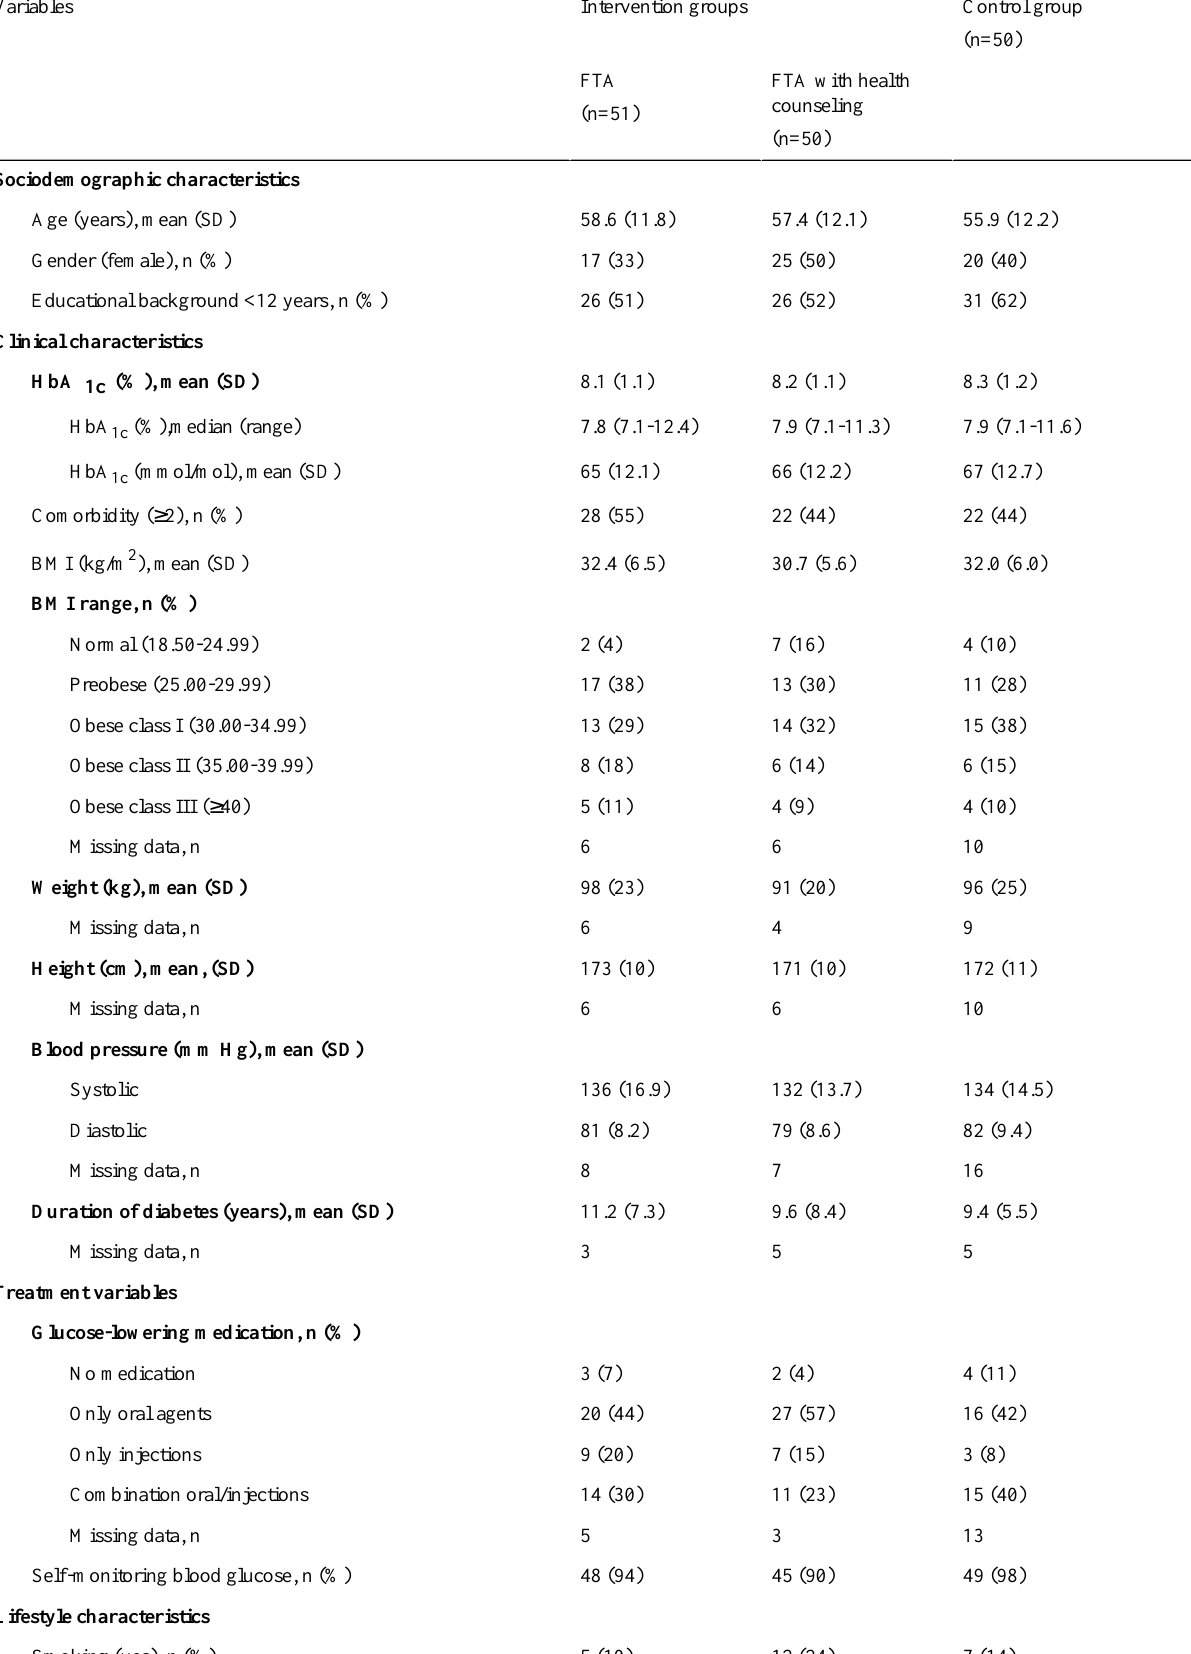
Table 2. Baseline characteristics of the control group and the 2 intervention